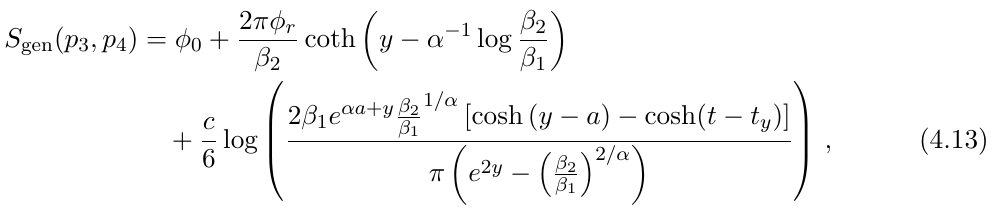
Figure 11. Page curves for the radiation segments plus the second black hole. We fix the physical reservoir size L = 0 . 5 , physical location of p R . (A) β = 2 . The no-island phase dominates at late times. (B) β φ r = c 2 6 dominates at late